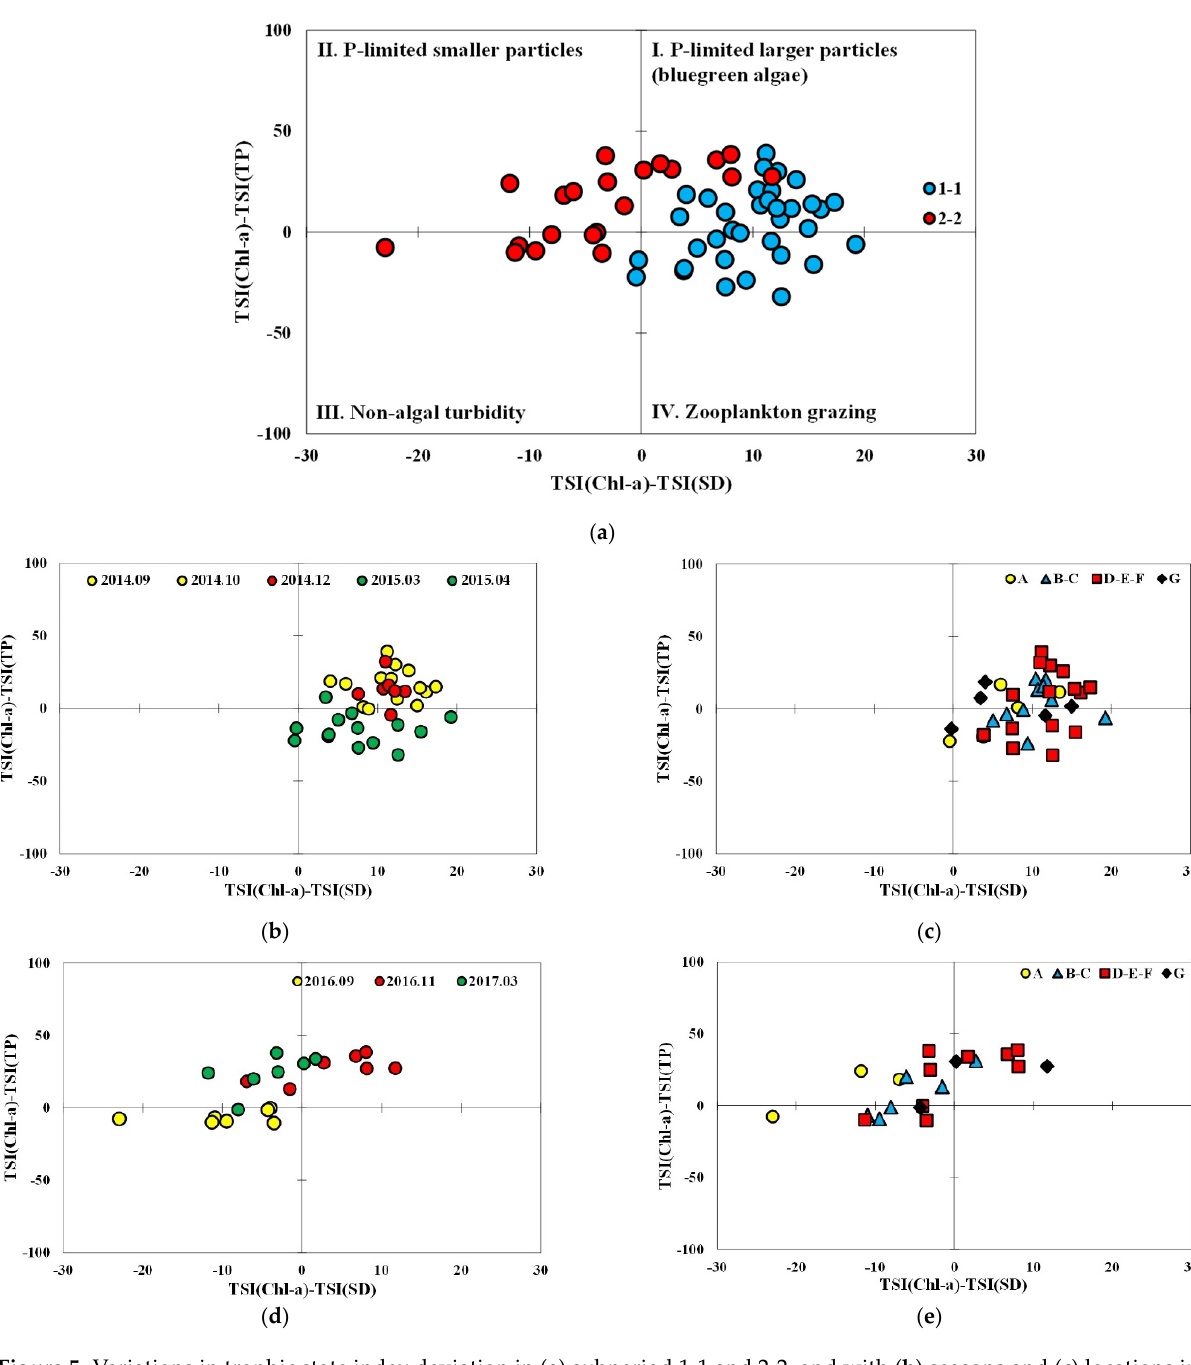
Figure 5. Variations in trophic state index deviation in ( a ) subperiod 1-1 and 2-2, and with ( b ) seasons and ( c ) locations in subperiod 1-1, and ( d ) seasons and ( e ) locations in subperiod 2-2.